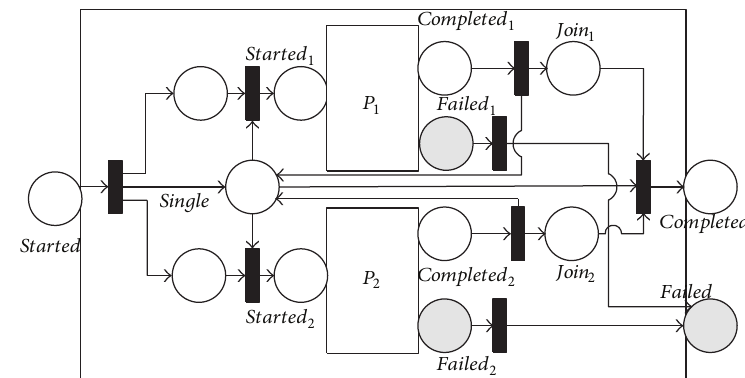
Figure 7: NMSPN model of the any-order process.